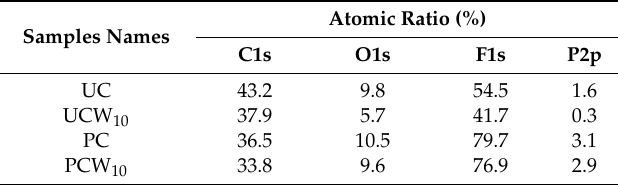
Table 2. Surface elements of aramid samples by XPS.